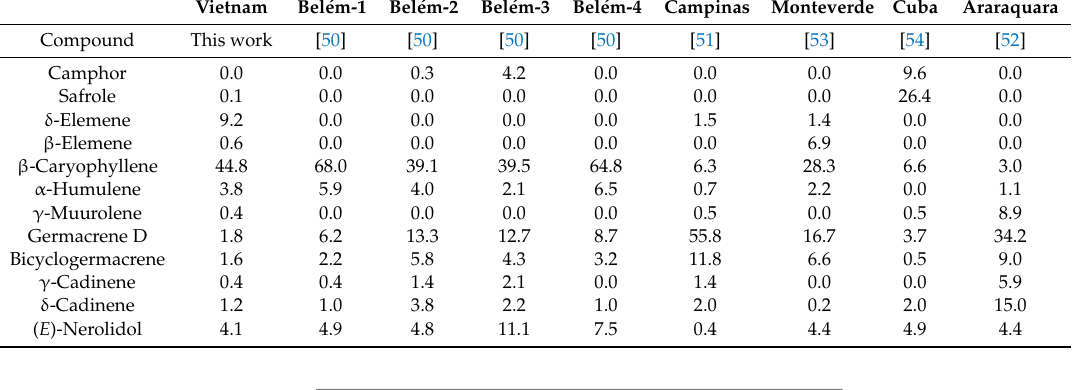
Table 3. Major essential oil components (%) of Piper umbellatum .